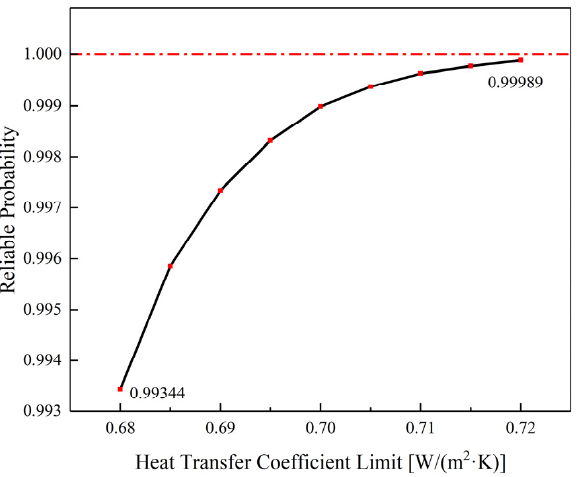
Figure 23. Heat transfer coefficient limit–reliability curve. Note: The red line is 100% reliability.